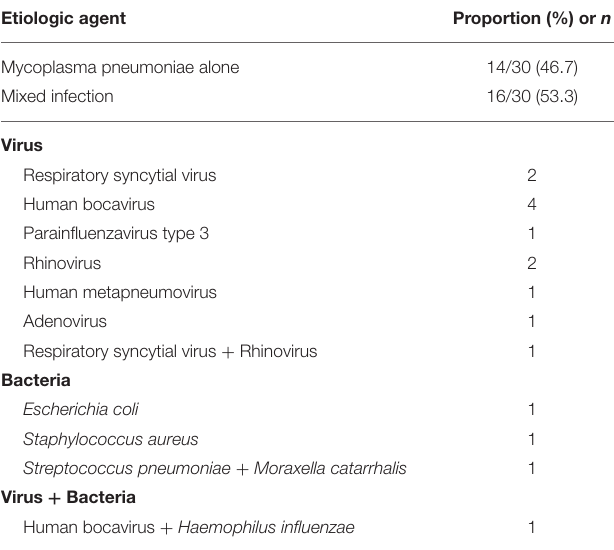
TABLE 3 | Etiologic agents of 30 patients with persistent wheezing. Etiologic